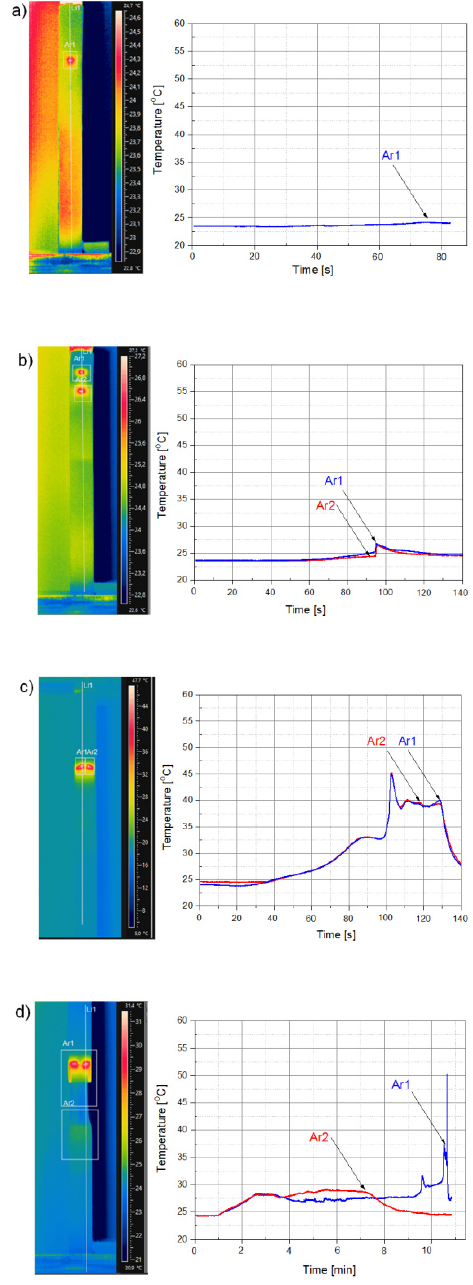
Figure 5. ( a – d ) IR thermograms for samples charged with maximal force during lap-shear test, and temperature traces adequate to rivet position in each sample from first to fourth rivet, respectively. Traces Ar1 and Ar2 illustrate evolution of maximal temperature recorded in sample area, indicated as Ar1 or Ar2, marked on each thermogram.